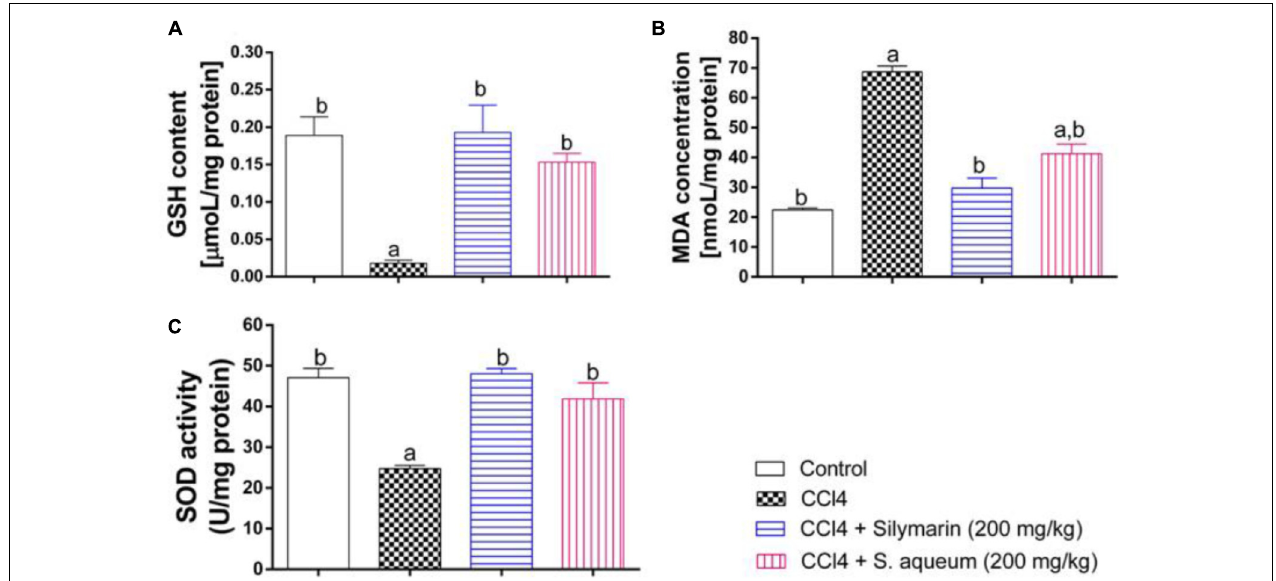
FIGURE 4 | Influence of a methanol extract of S. aqueum leaves on antioxidative enzyme activities in rats with acute CCl 4 intoxication. (A) Liver glutathione (GSH); (B) Lipid peroxidation and generation of malondialdehyde (MDA); (C) Superoxide dismutase (SOD). Results are shown as means ± SD, n = 6, by one-way ANOVA followed by Tukey post hoc test. a Statistically significant from the corresponding control at p < 0.05, b Statistically significant from CCl 4 -treated group at p <